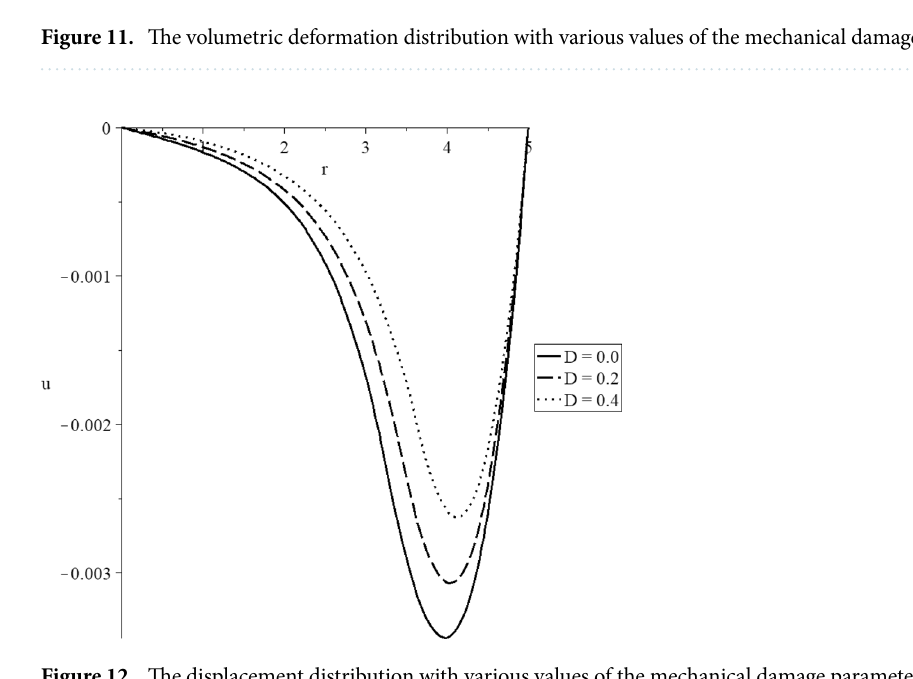
Figure 12. The displacement distribution with various values of the mechanical damage